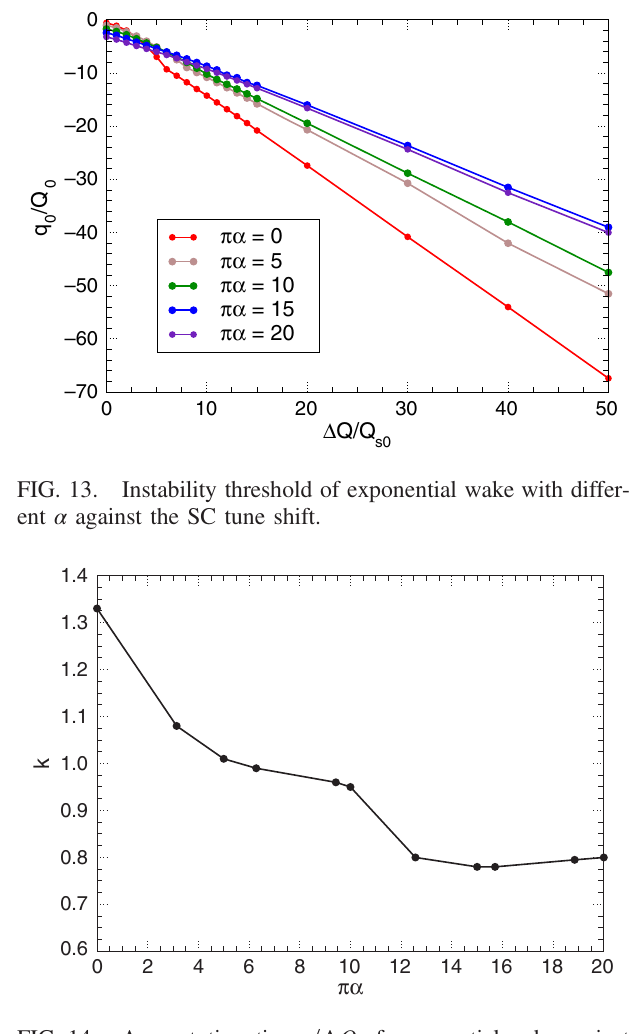
FIG. 14. Asymptotic ratio q 0 = Δ Q of exponential wake against the damp